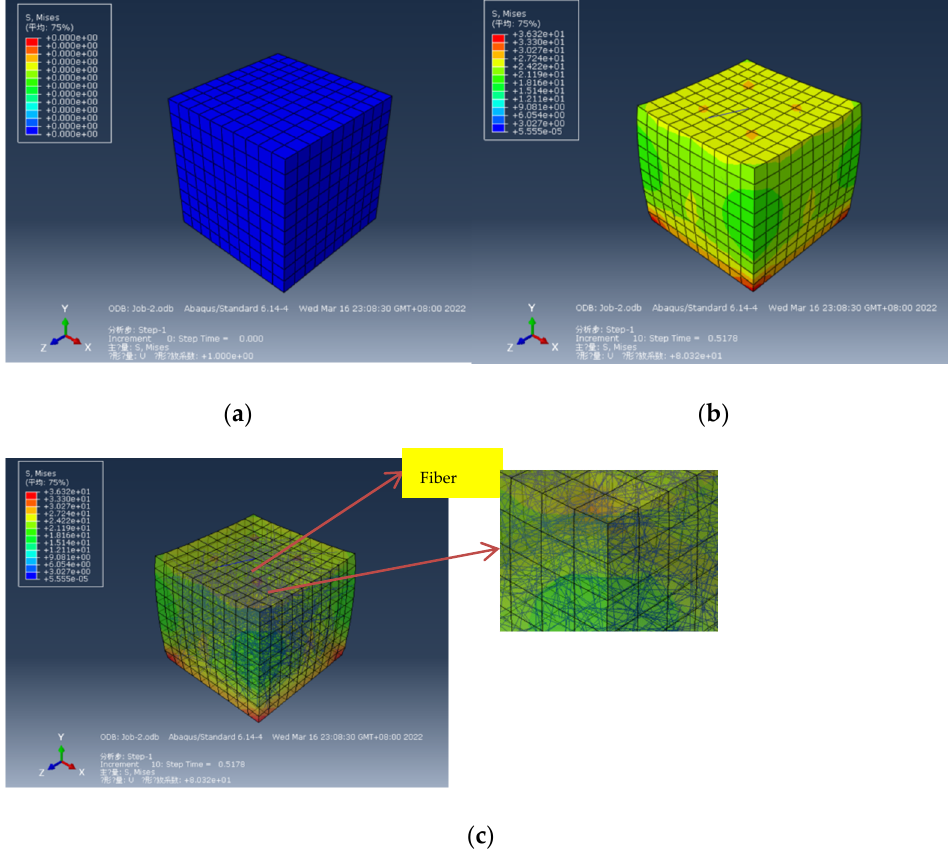
Figure 13. Simulation diagram of compression test: ( a ) Stress cloud diagram before force; ( b ) Stress cloud diagram after force; ( c ) ABAQUS simulated stress perspective cloud diagram.